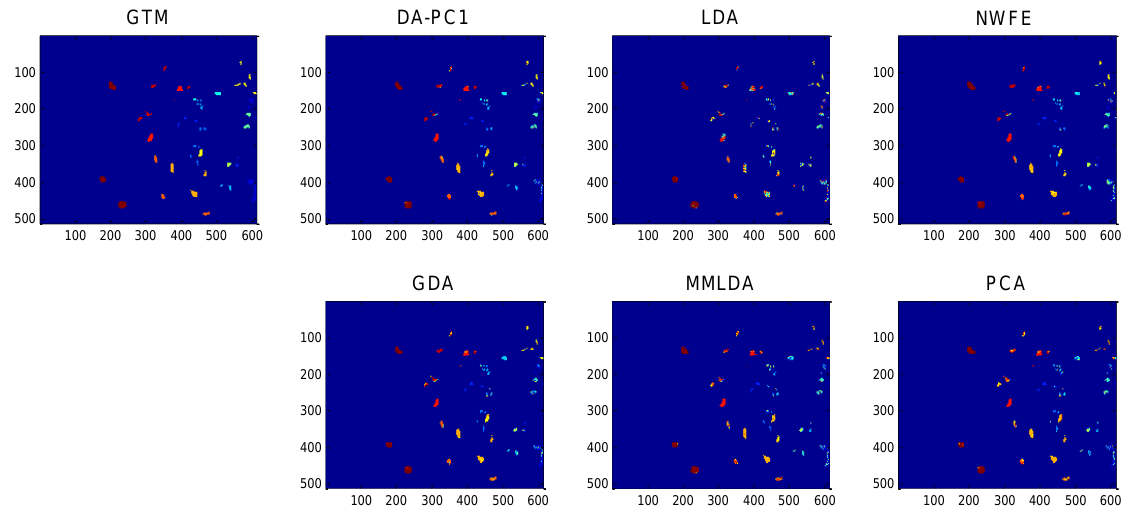
Figure 4. GTM and the classification maps of KSC dataset obtained by SVM classifier, 15 training samples and 8 extracted features. Table 4. The highest classification accuracies achieved by 15 training